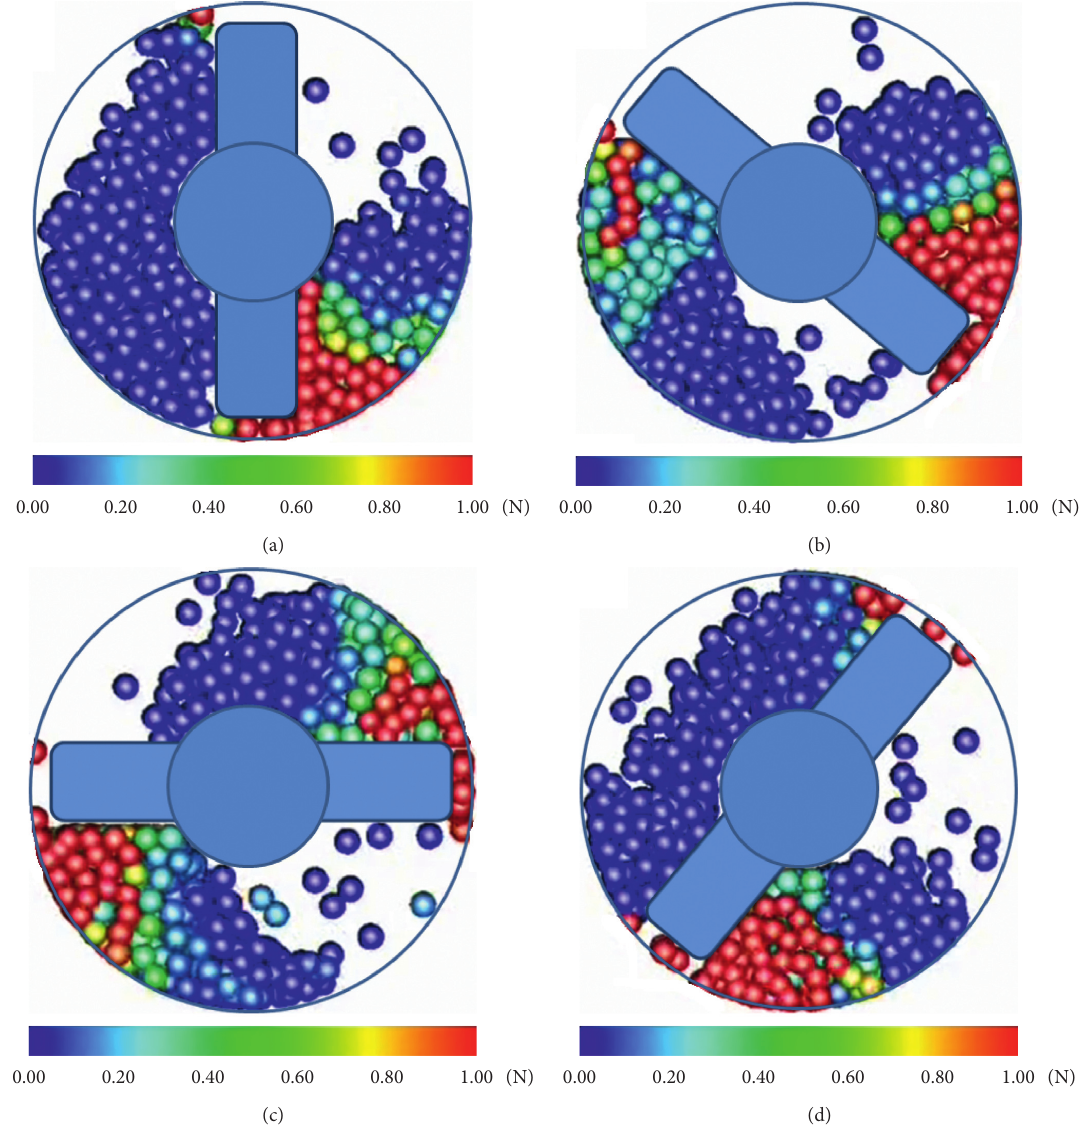
Figure 9: Compressive force acting on the particle inside the rotary damper with the gap model; the packing fraction is 50%, and the rotational speed is 60rpm. (a) 0 degree, (b) 45 degrees, (c) 90 degrees, and (d) 135 degrees. The direction of rotation is